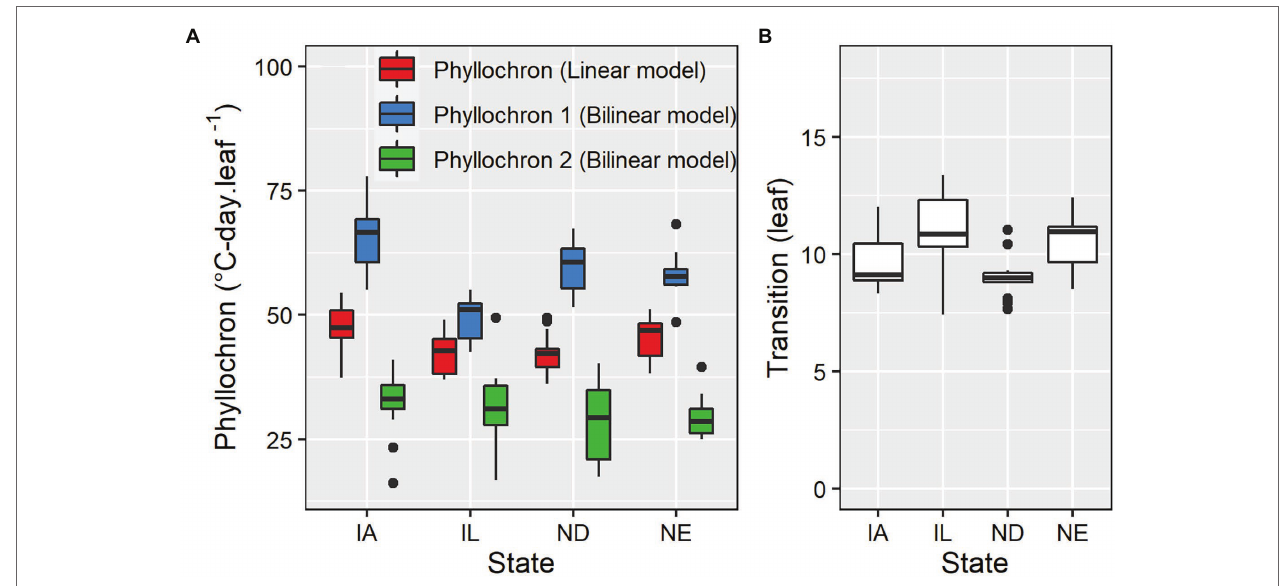
FIGURE 3 | Phyllochron parameter values for linear and bilinear models (A) and transition leaf number for the bilinear model (B) for datasets in IA ( n = 64), IL ( n = 13), ND ( n = 13), and NE ( n =